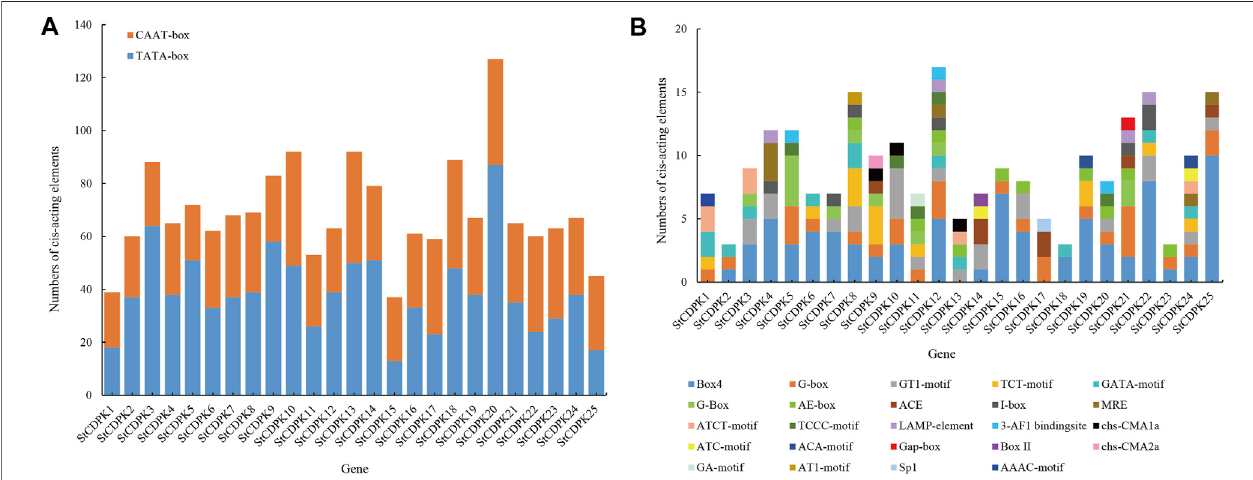
FIGURE 4 | (A) Distribution maps of core promoter elements of the StCDPKs family. The core promoters were divided into two groups; CAAT-box and TATA-box indicated by brown and blue colors respectively. The PlantCARE website and database were used to identify the promoter elements of the 25 StCDPK genes. (B) Distributionmapofphotoresponsivefunctionalelementsinthepromotersofthe StCDPKs family.Theanalysisrevealed24photo-responsiveelementsdistributedacross the identi fi ed CDPK genes. Each gene carries at least 2 photoresponsive elements at its promoter site as revealed by the PlantCARE (http://bioinfomatics.psb. ugent.be/webtools/plantcare/html) online